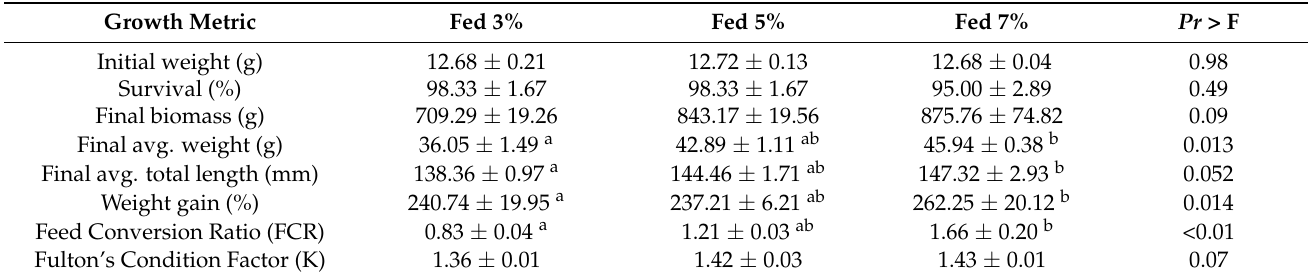
Table 1. Growth metrics of northern Largemouth bass fingerlings (Trial